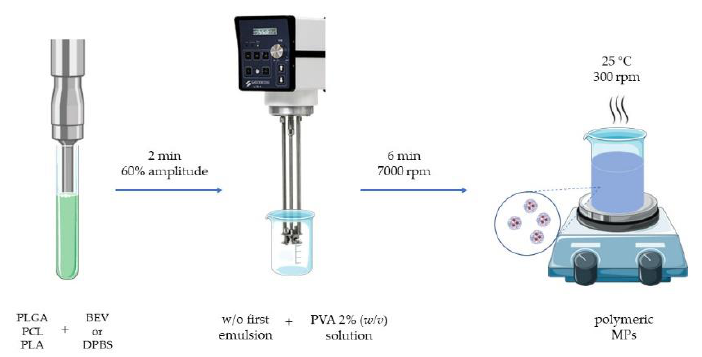
Figure 1. Schematic representation of MP production process. PLGA: poly(lactic- co -glycolic acid), PCL: poly( ε -caprolactone), PLA: poly(lactic acid), BEV: bevacizumab, DPBS: Dulbecco’s phosphate buffered saline, PVA: poly(vinyl alcohol), rpm: revolutions per minute, MPs: microparticles.